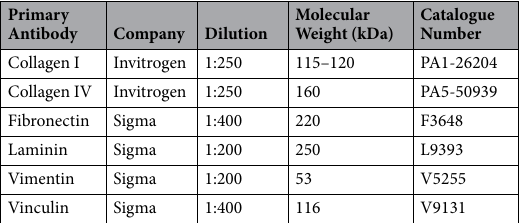
Table 2. Antibodies used for immunofluorescence staining (IFS). The corresponding secondary antibodies – Anti-rabbit IgG (H + L), F(ab’) 2 Fragment (Alexa Fluor ® 488 Conjugate) (Ref. 4412S) and Anti-mouse IgG